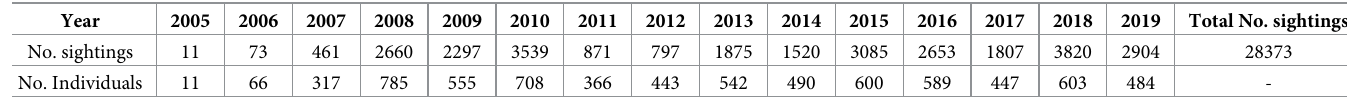
Table 4. Summary of all photo identification records from the key habitats.